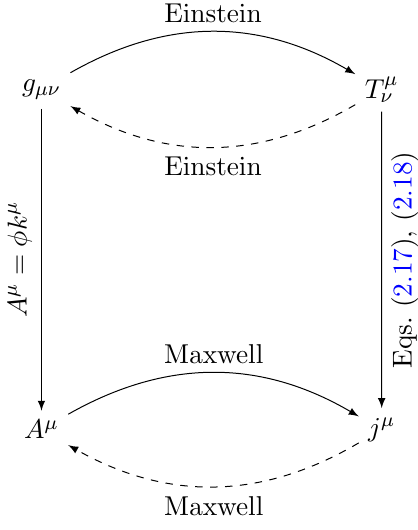
Figure 1 . The relationships between the gravity solution g (cid:22)(cid:23) , the gauge (cid:12)eld A (cid:22) , the gravity source T (cid:22) , and the gauge source j (cid:22) . Dashed lines denote directions which require solving equations (cid:23) of